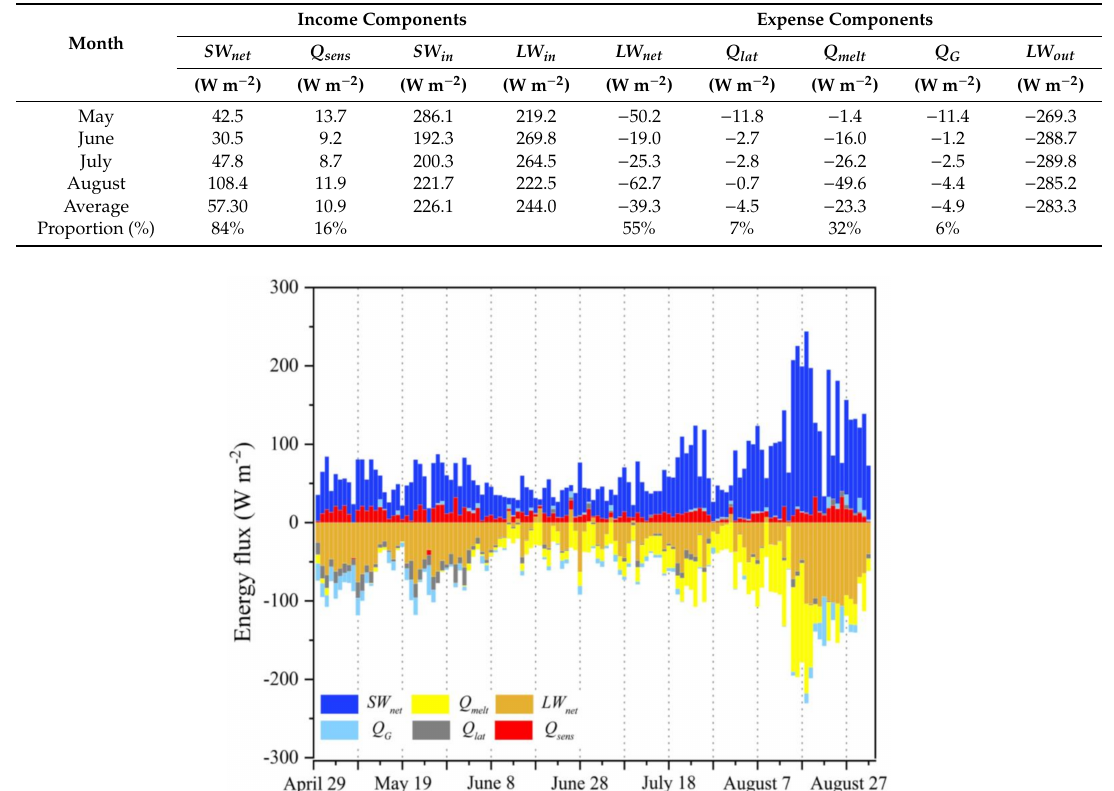
Table 3. Monthly mean values of energy flux components (W m − 2 ) and proportional contribution of each flux (%).